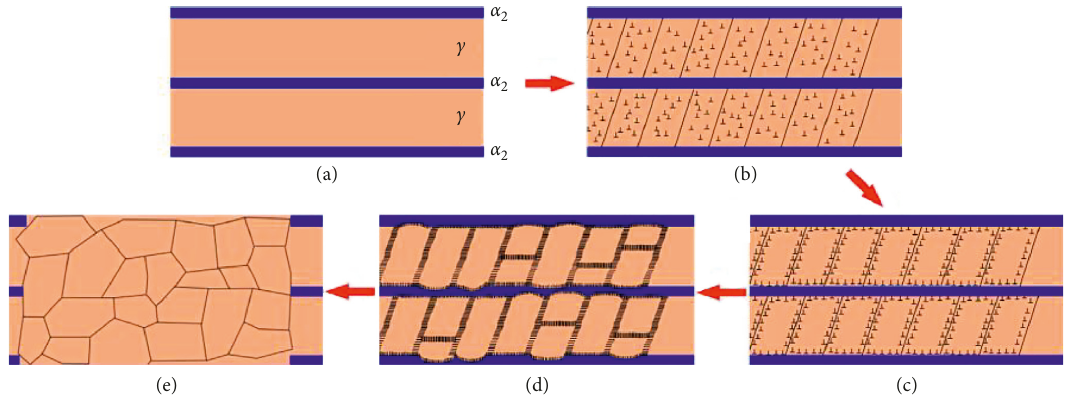
Figure 13: Schematic illustration showing the DRX process in the α